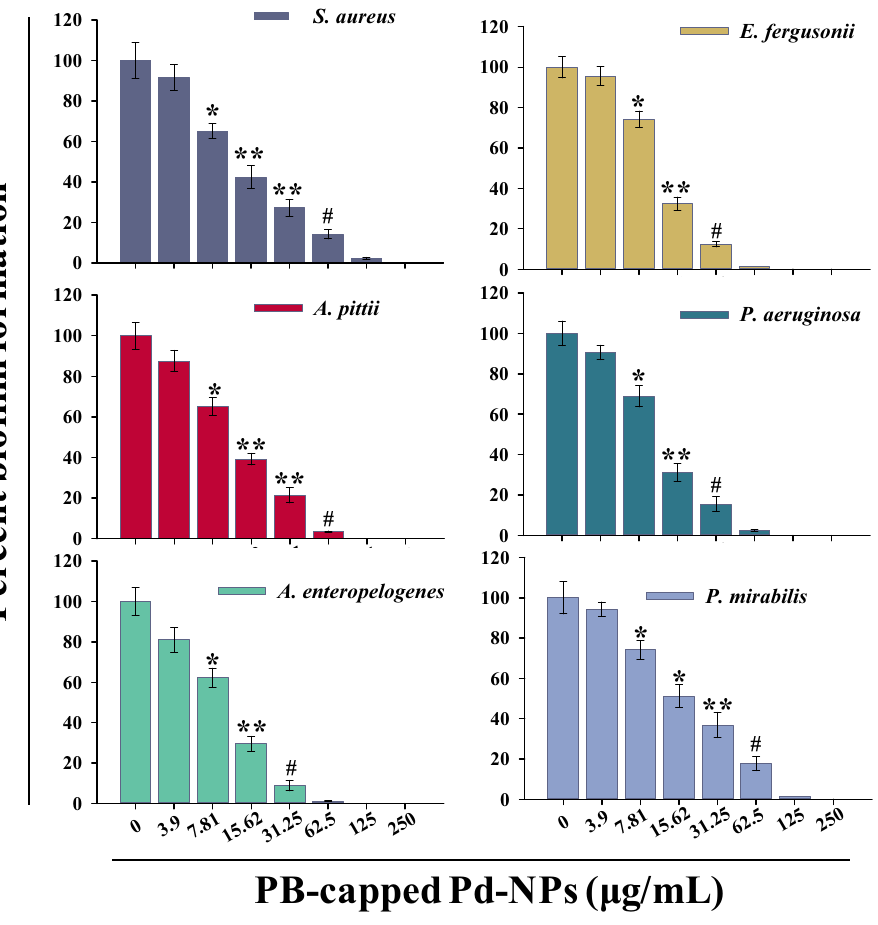
Figure 8. PB extract-capped Pd-NPs (3.9–250 µg/mL) dependent biofilm formation by bacterial cultures over respective untreated controls. Data represents mean values of three independent replicates and error bars represent standard deviation (S.D.). * P ≤ 0.05, ** P ≤ 0.01, # P ≤ 0.001 based on student’s